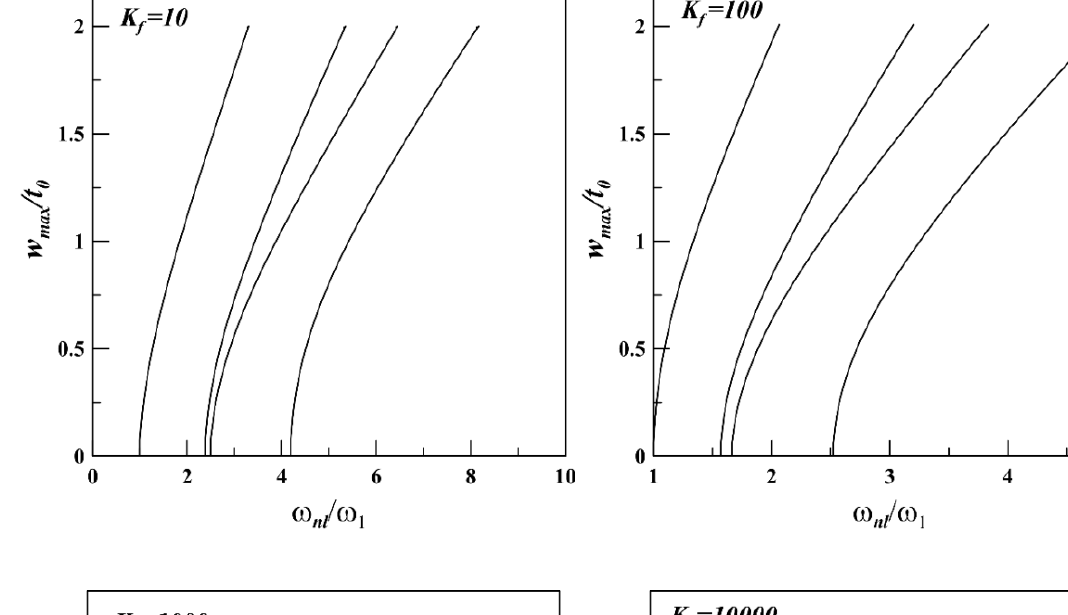
served between backbone 3 and 4 at K